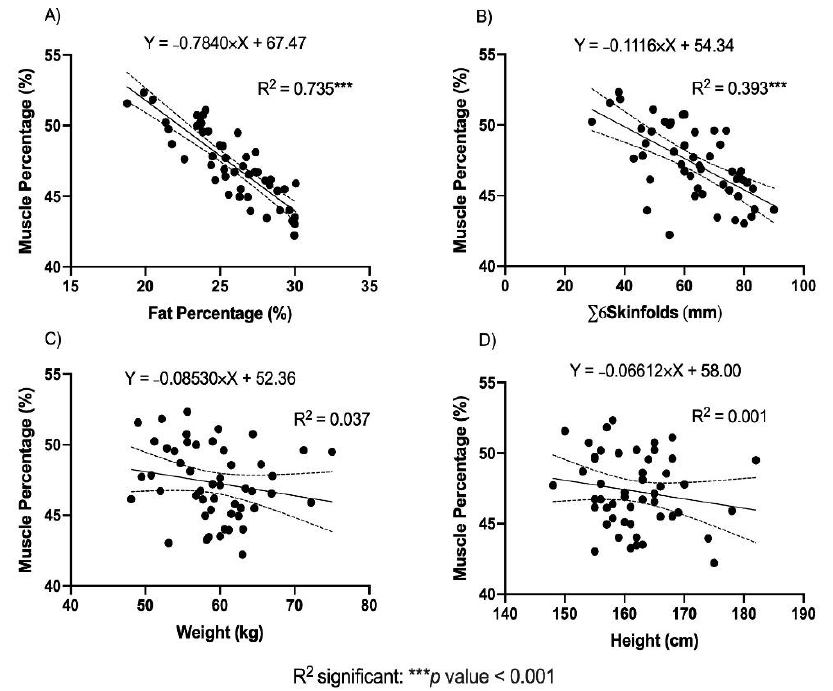
Figure 4. Simple linear regressions between muscle percentage and anthropometric variables ( A ): Fat Percentage; ( B ) : Σ6Skinfolds; ( C ): Weight and ( D ): Height.